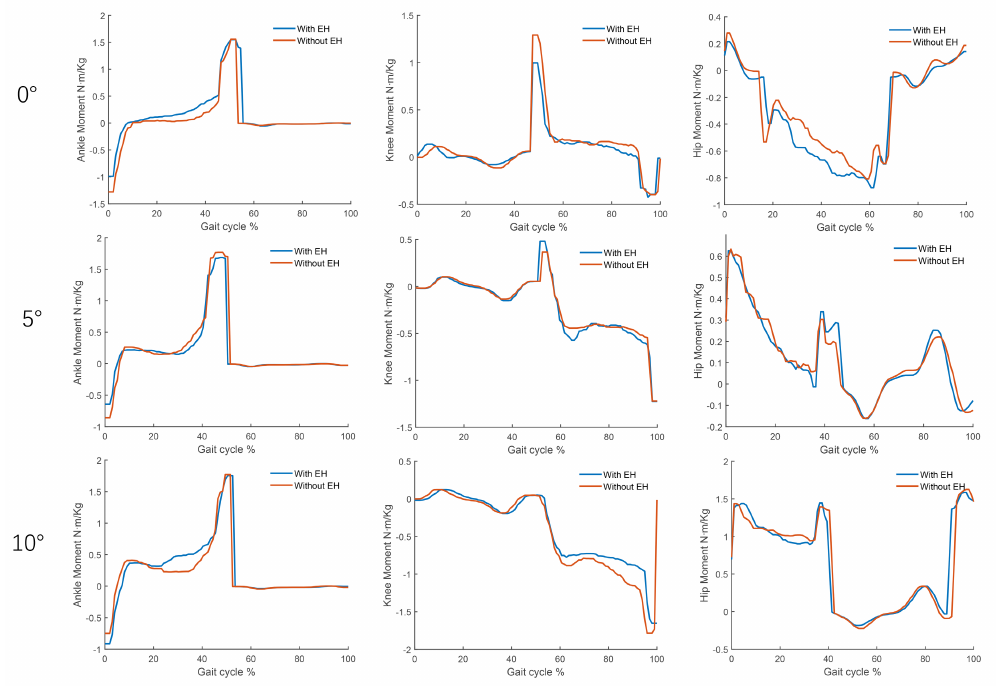
Figure 8. The biological moment curves of ankle joint, knee joint and hip joint with and without the EH device at different